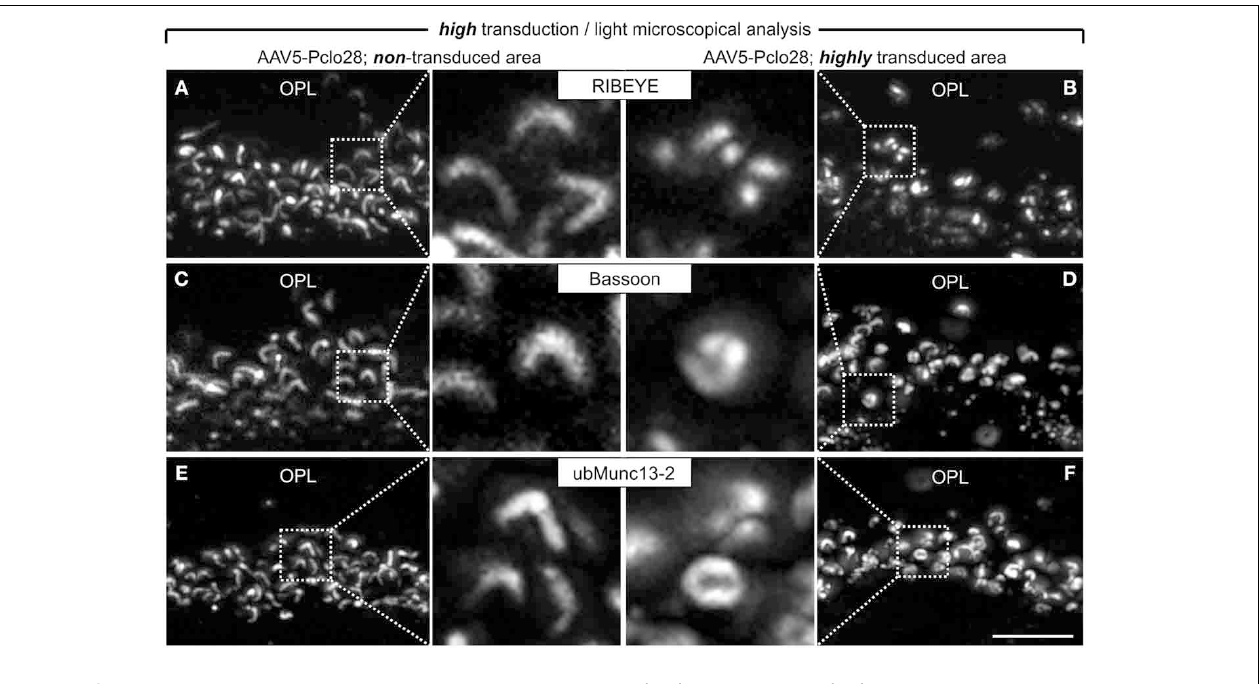
(C,D) , and ubMunc13-2 (E,F) in AAV5-Pclo28-transduced retina 8w p.i. For a given staining, images were taken from a non-transduced (A,C,E) and a highly transduced area (B,D,F) of the same retinal slice. GFP fluorescence is not shown. OPL: outer plexiform layer. Scale bar in (F) for (A–F) : 5 μ